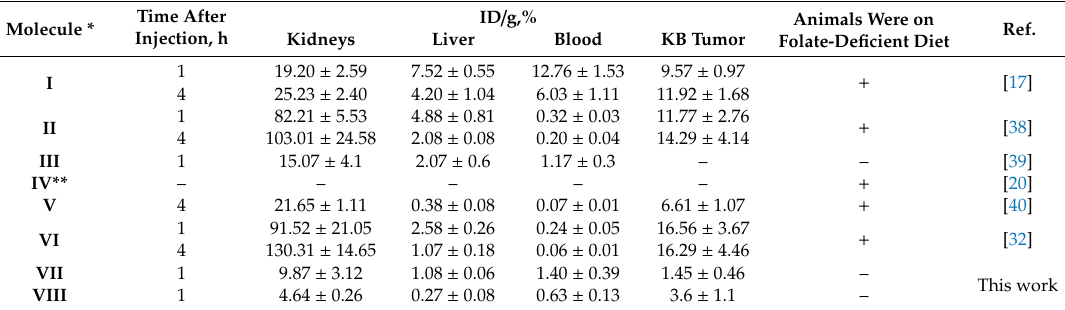
ID / g,% Animals Were on